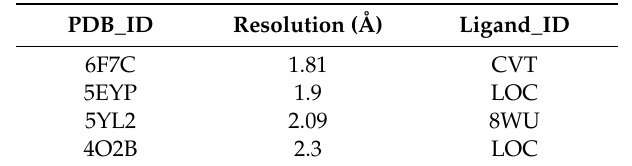
inhibitor binding of the tubulin: (i) Two Acc and Aro features (F1 and F2) corresponding to Leu240, Ala248, Leu253, and water molecules; (ii) two Aro and Hyd features (F3 and F4) corresponding to Met257, Ala314, Val181, and Lys350.